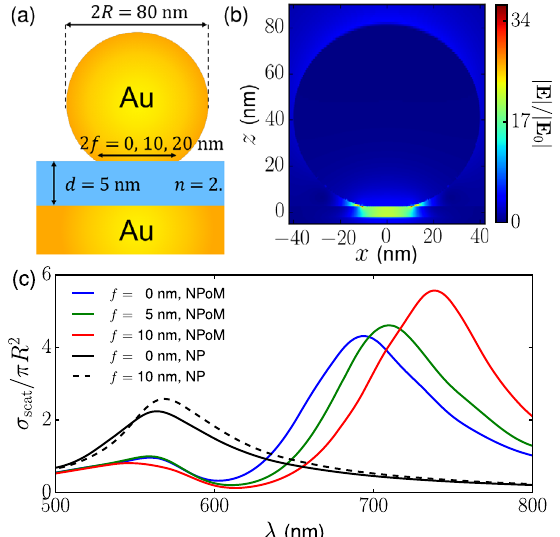
Fig. 1. (a) Schematic diagram of a nanoparticle-on-mirror (NPoM) nanocavity with diameter 2 R = 80nm, facet diameter 2 f and gap size d = 5nm. (b) The fi eld enhancement distribution j E j = j E 0 j of the bonding dipole plasmon (BDP) of the NPoM with f =10 nm (c) Scattering cross-section s scat for the NPoM with f =0, 5 and 10nm and for nanoparticles (NPs) on plain dielectric substrates with f =0 and 10